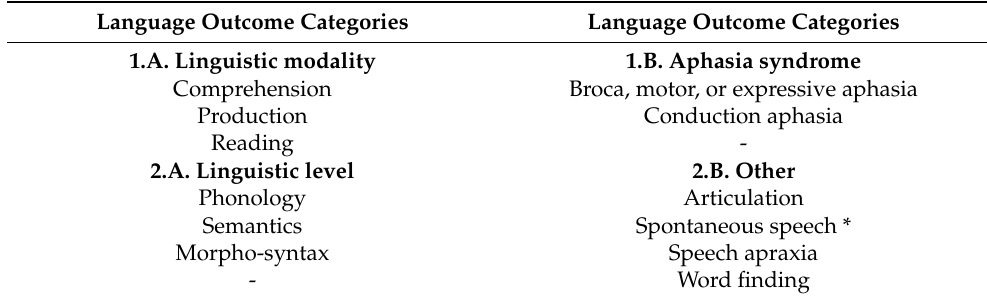
Table 2. The language outcome categories defined by (1) linguistic modality or aphasia syndrome and (2) linguistic level or other